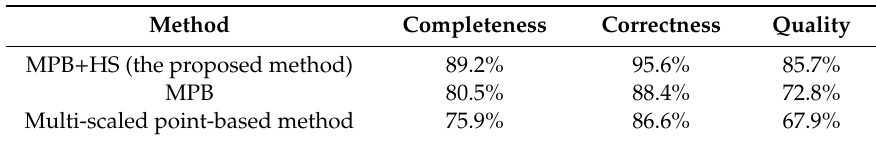
Table 5. Evaluations of the semantic labeling results of the Hong Kong sites using the proposed method. MPB: multi-primitive-based; HS: hierarchical